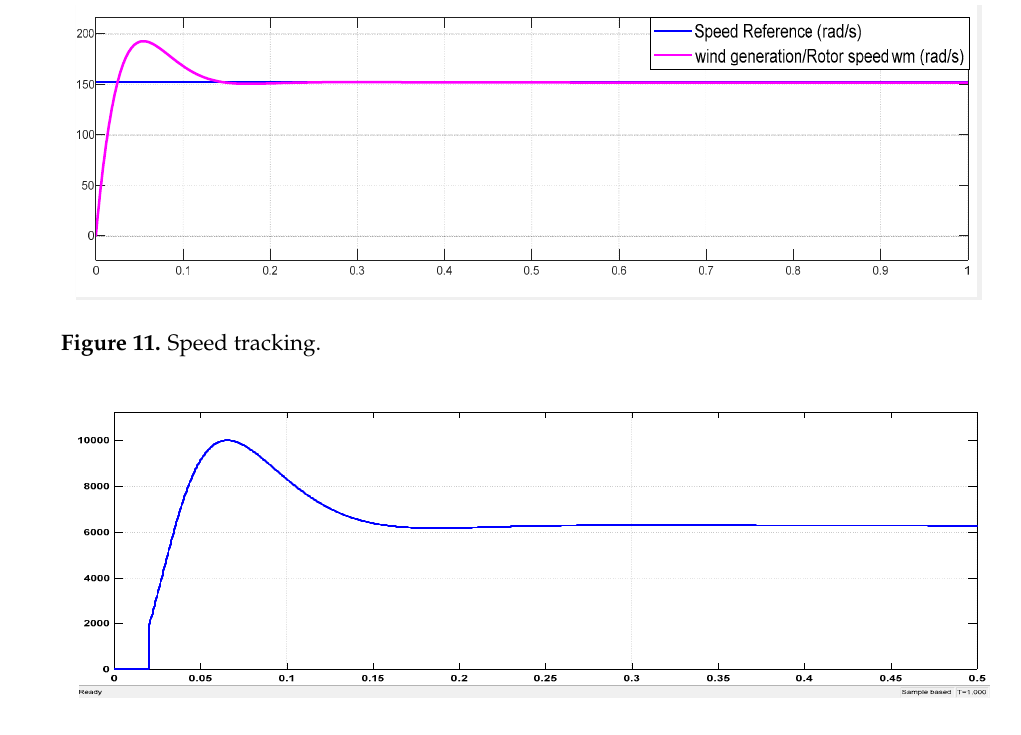
Figure 10. Electromagnetic torque.